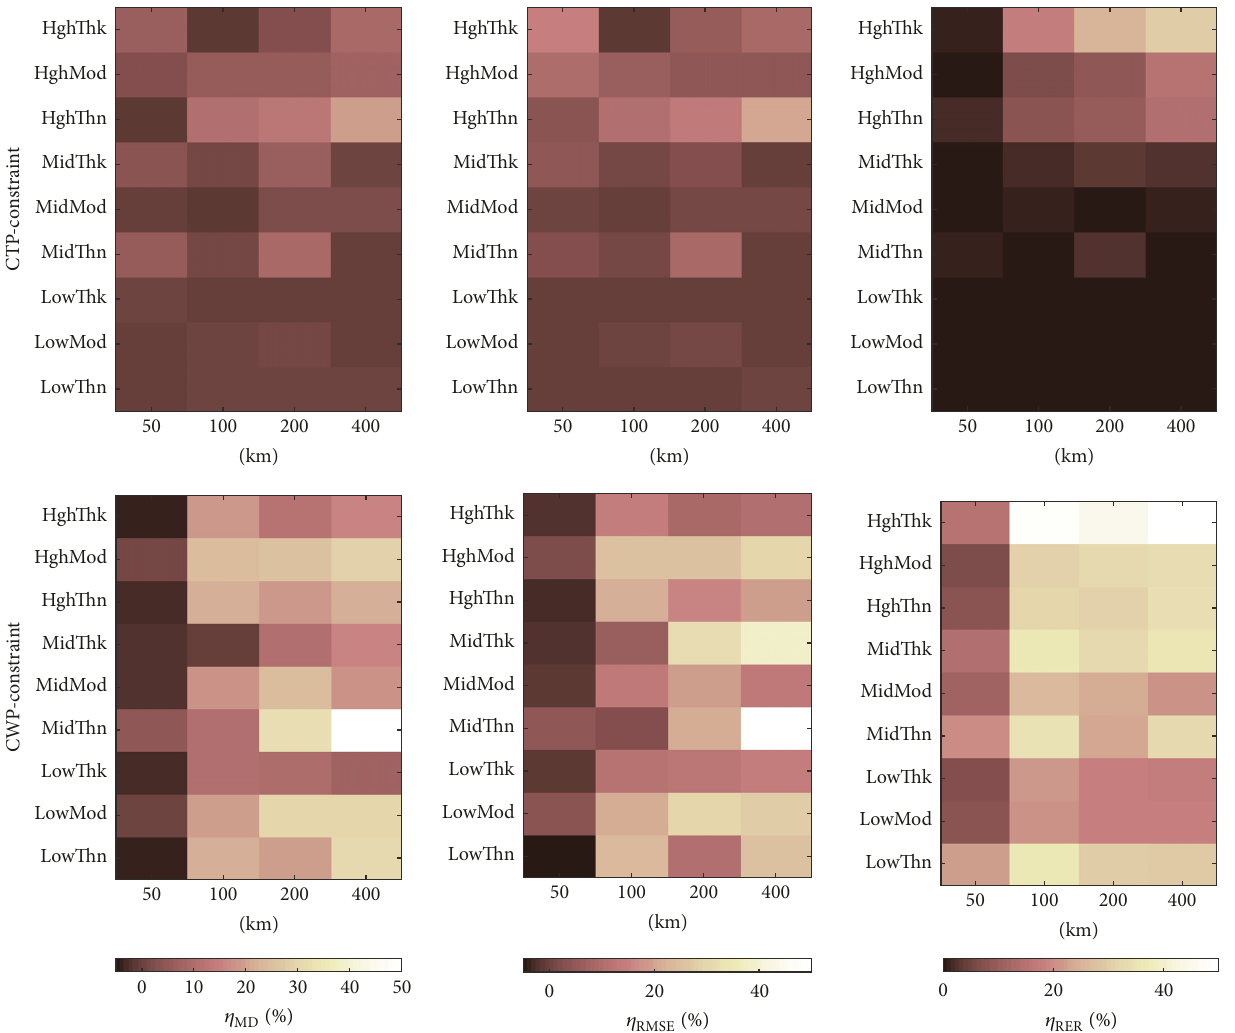
Figure 6: Statistical performances of CTP and CWP constraints for CBH estimation as functions of exclusion distances (50, 100, 200, and 400 km) when 𝛼 = 0.3 . The three columns show (left to right) 𝜂 MD ( % ) , 𝜂 RMSE ( % ) , and 𝜂 RER ( % ) , respectively. Within each panel, the nine ISCCP cloud types are